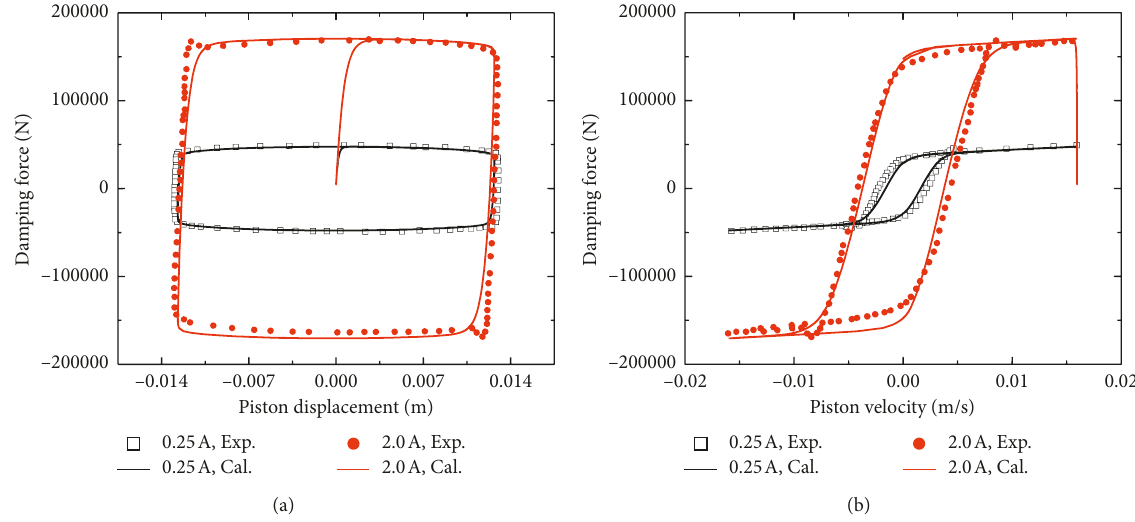
Figure 13: Model predictions (lines) and experimental data (Yang [34]) of hysteretic behavior of MR dampers under sinusoidal dis- placement excitations of 1.27cm, 0.2 Hz. (a) Displacement-force hysteresis. (b) Velocity-force